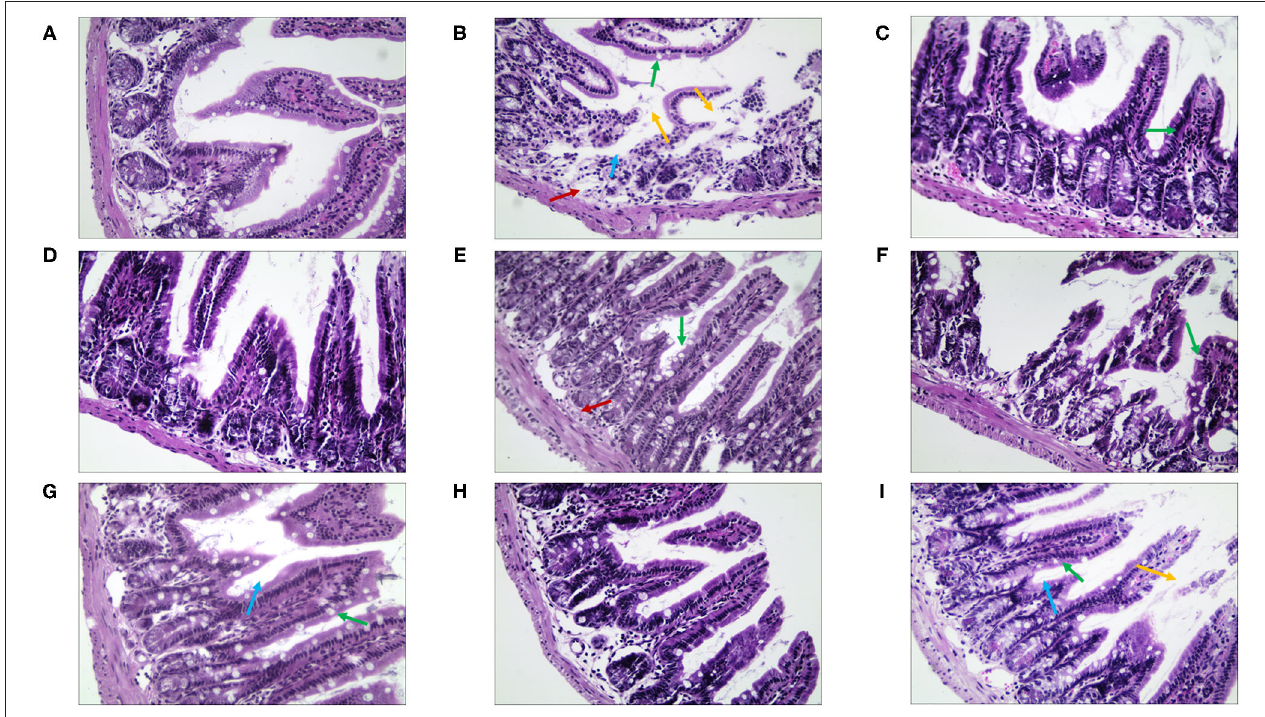
FIGURE 10 | The morphological and histopathological changes (H&E, × 50 magnification) of the ileum tissues in diarrhea mice. (A) Normal control (NC) group, (B) model control (MC) group, (C) positive control (PC) group, (D) QJC group, (E) quercetin group, (F) kaempferol group, (G) luteolin group, (H) scutellarein group, and (I) stigmasterol group. Yellow arrow: exfoliated mucosal epithelial cells; blue arrow: intestinal crypts; green arrow: goblet cells; red arrow: loose connective tissue; original magnification: × 50, n = 5 per